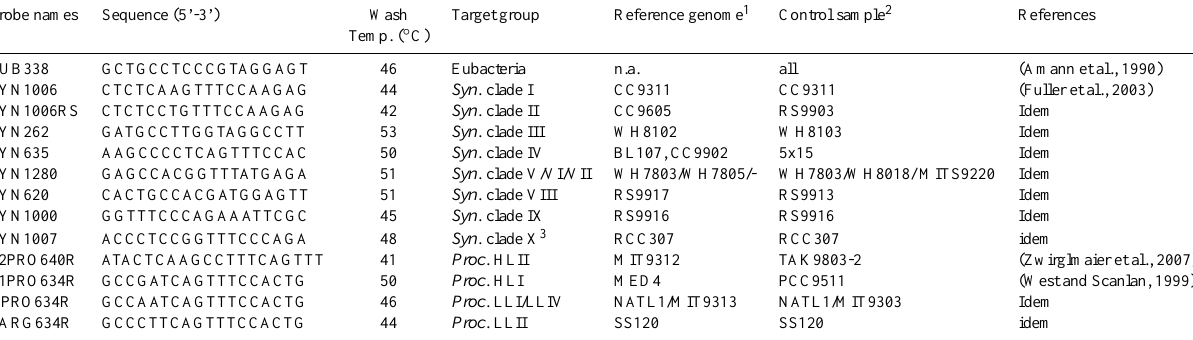
Table 1. Characteristics of 16S rDNA oligonucleotide probes used for dot blot hybridization. Abbreviations: Syn ., Synechococcus ; Proc ., Prochlorococcus ; n.a., not